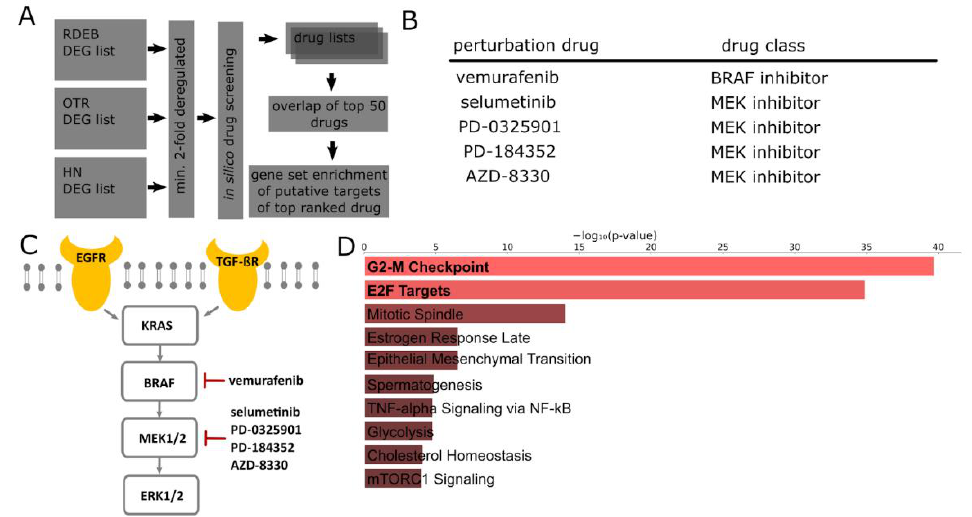
Figure 2 . Drug candidate nomination. ( A ) Schematic workflow of the employed computational drug screening approach. ( B ) L1000CDS2 search engine-derived drug catalogues with common drugs targeting the MEK signaling cascade. ( C ) Schematic of the MEK signaling cascade and target molecules of selected perturbation drugs based on results of our in silico screening approach. ( D ) Barplot shows MSigDB hallmark gene sets significantly enriched in, e.g., up-regulated RDEB DEGs, which are putative targets of vemurafenib reported by the L1000 characteristic direction signature (CDS)2 drug screening algorithm.